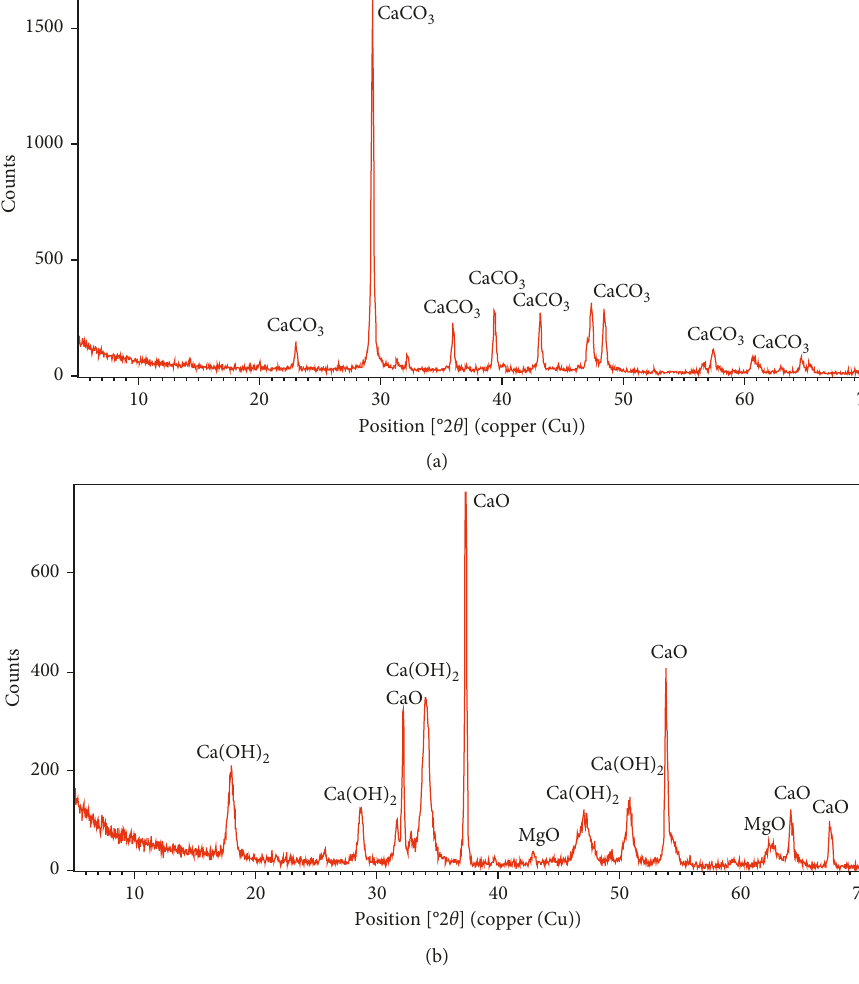
Figure 8: XRD patterns of (a) sugar scum powder and (b) optimal